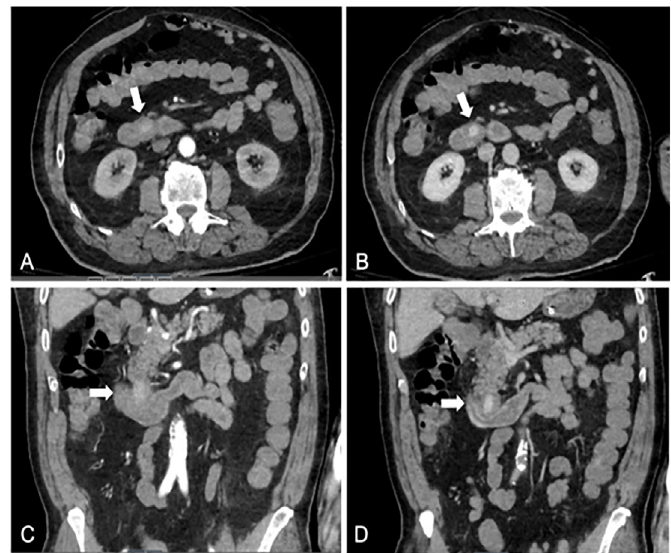
Image 1. Computed tomography angiogram of abdomen showing submucosal duodenal pseudoaneurysm (white arrows) causing massive gastrointestinal hemorrhage in (A) transverse plane arterial phase, (B) transverse plane venous phase, (C) coronal plane arterial phase, and (D) coronal plane venous phase.